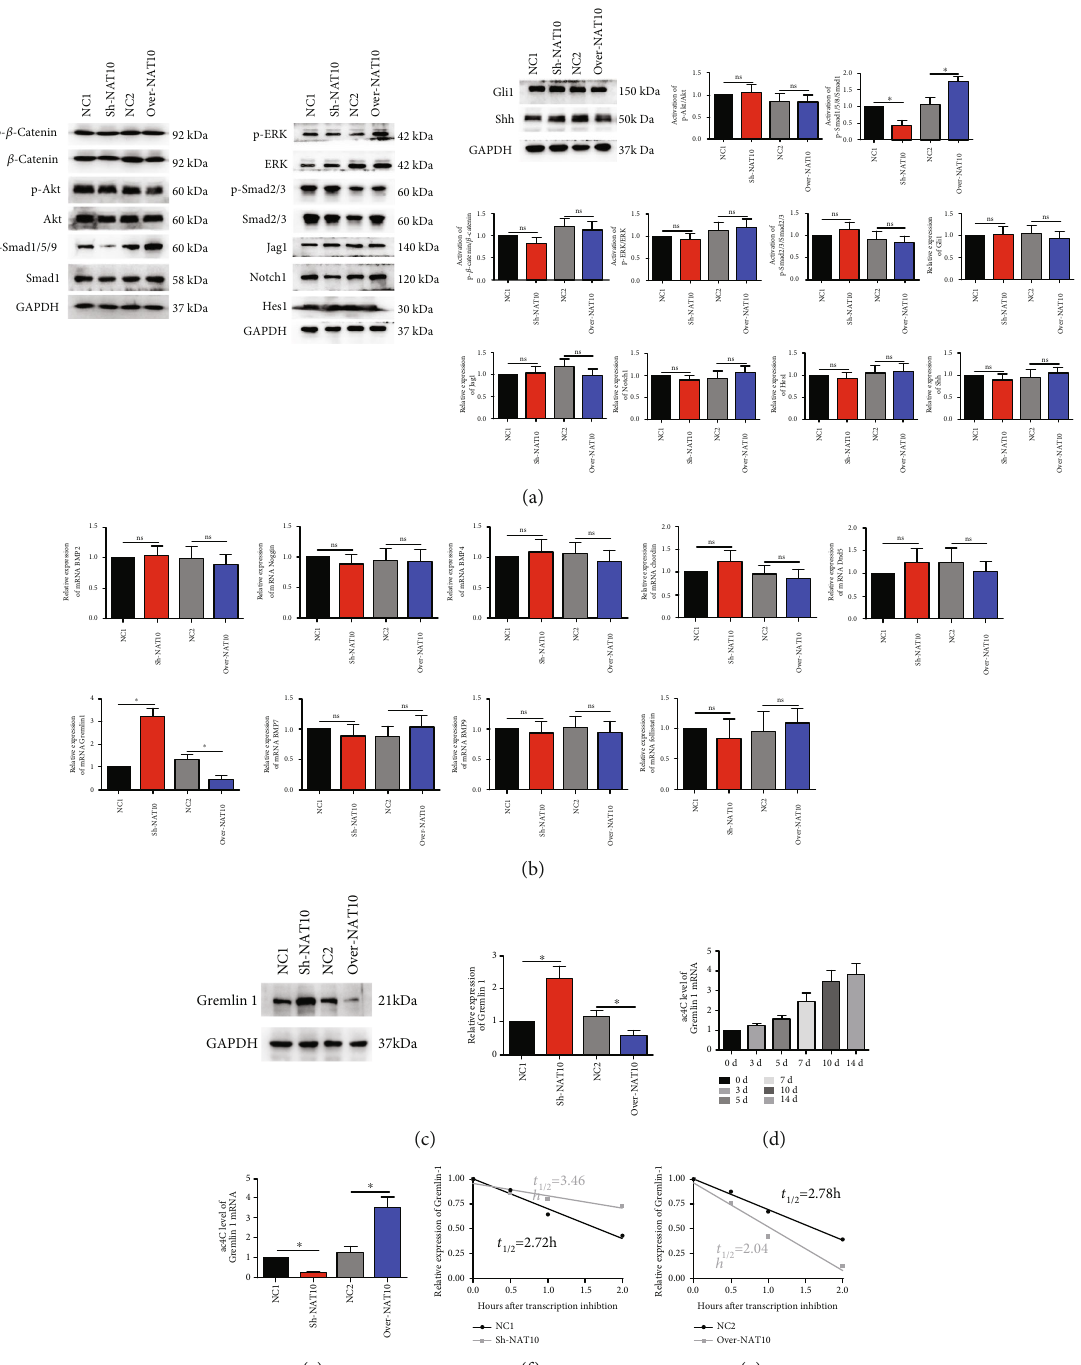
Figure 3: NAT10 regulated the activation of the Smad1/5/9 signaling pathway and the expression of Gremlin 1 through ac 4 C modi fi cation. (a) The phosphorylation levels of Smad1/5/9 signaling pathway components were decreased in the Sh-NAT10 group but increased in the Over-NAT10 group. The activation levels of β -Catenin, Akt, Smad2/3, FGF/ERK, Noggin, and Hedgehog signaling pathway components remained stable in the di ff erent groups. (b) The mRNA level of Gremlin 1 was increased in the Sh-NAT10 group but decreased in the Over-NAT10 group. The mRNA levels of BMP2, Noggin, BMP4, BMP7, BMP9, Dand5, Follistatin, and Chordin remained stable in the di ff erent groups. (c) The protein level of Gremlin 1 was increased in the Sh-NAT10 group but decreased in the Over-NAT10 group. (d) The ac 4 C level in Gremlin 1 mRNA increased gradually from day 0 to day 14 of MSC osteogenesis. (e) The ac 4 C level in Gremlin 1 was lower in the Sh-NAT10 group and higher in the Over-NAT10 group than in the NC group. (f) The degradation rate of Gremlin 1 mRNA was slower in the Sh-NAT10 group than in the NC group. (g) The degradation rate of Gremlin 1 mRNA was higher in the Over-NAT10 group than in the NC group. ∗ indicates P < 0 : 05 . All experiments were repeated three